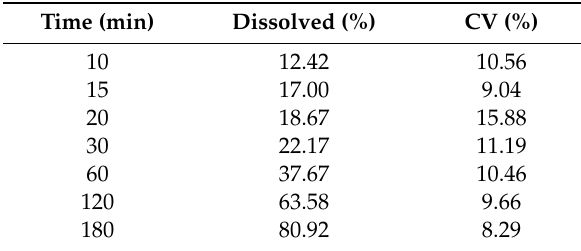
Table 2. Accuracy and precision data for the determination of diltiazem (DTZ) and desacetyl DTZ (DTZM) in human plasma.